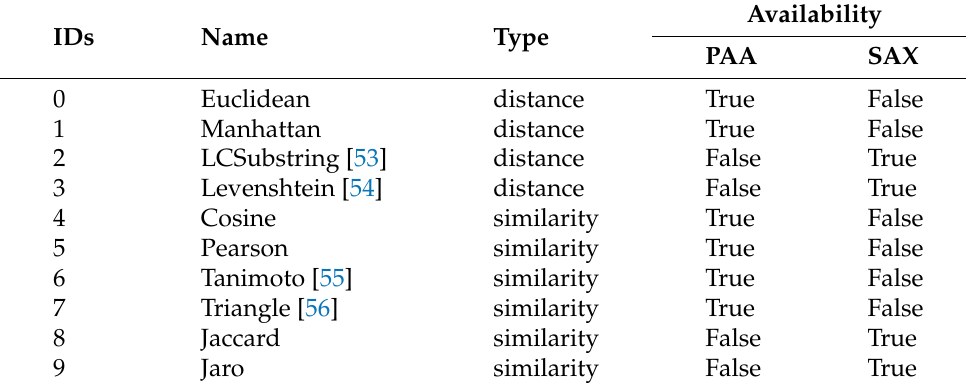
Table 4. The availability of similarities and